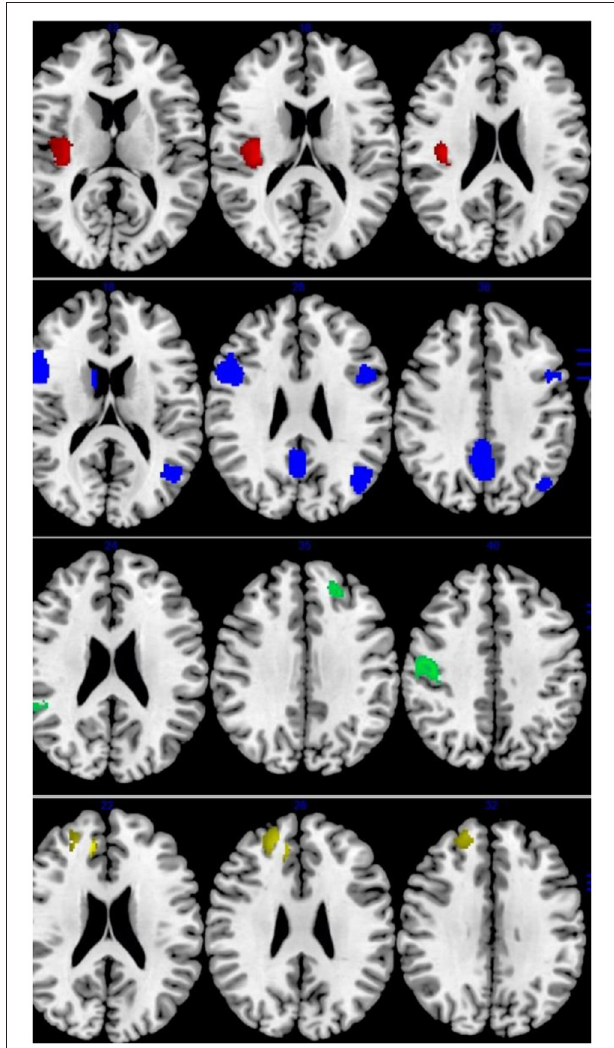
FIGURE 3 | Results of Functional Magnetic Resonance Imaging (fMRI) for IGD and ADHD. Results of fMRI meta-analysis for, from top to bottom, patients with Internet gaming disorder (IGD) relative to controls (red: increased in IGD; blue: decreased in IGD), patients with attention-deficit/hyperactivity disorder (ADHD) relative to controls (green: increased in ADHD; yellow: decreased in